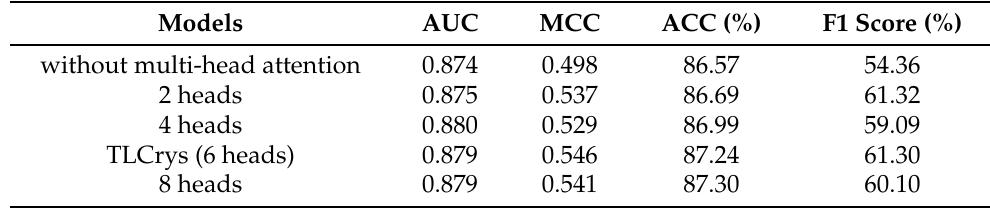
Table 4. Ablation experiments on CRYs task.